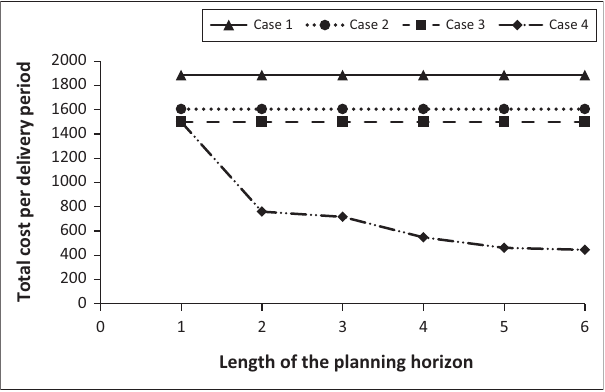
FIGURE 5: Cost per delivery period versus planning TABLE 5: The total cost per period resulted from the mixed-integer quadratic problem for different planning periods. Planning period